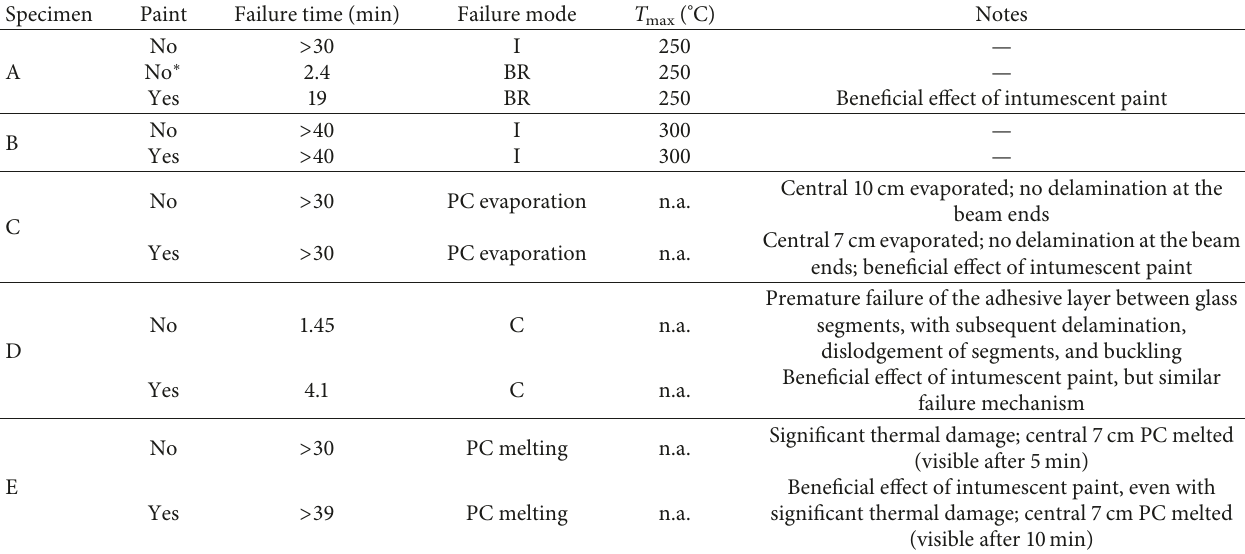
Table 3: Summary of bending test results reported in [22].